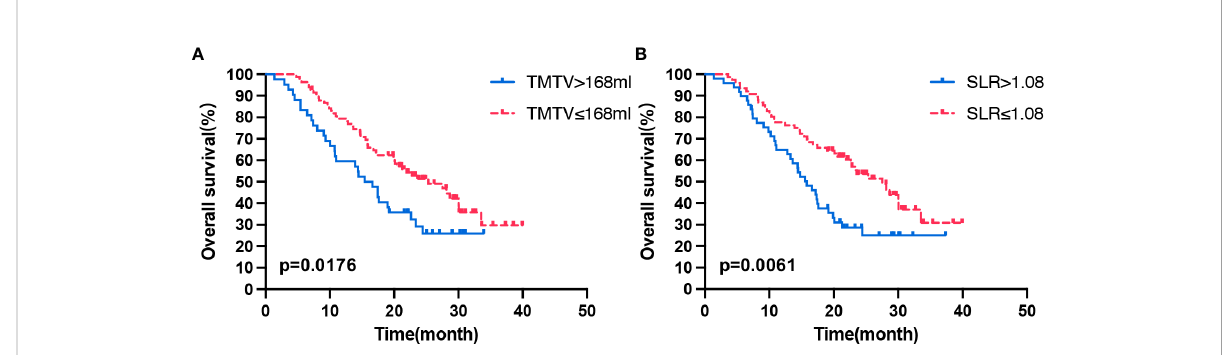
Changes in PET metabolic parameters was correlated with survival With respect to the correlation between changes in PET/CT